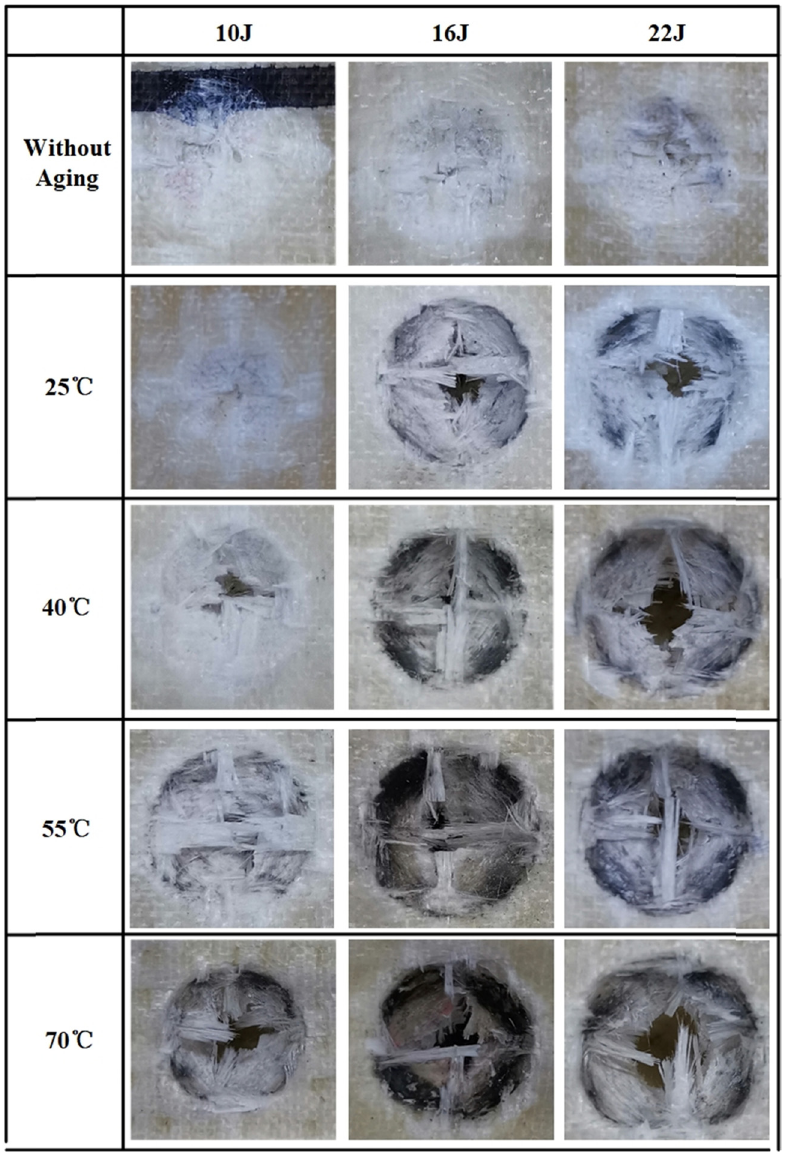
Figure 9: Typical damage morphology of front surfaces: natural aging – 30 days, 25°C – 30 days, 40°C – 30 days, 55°C – 30 days, and 70°C – 30